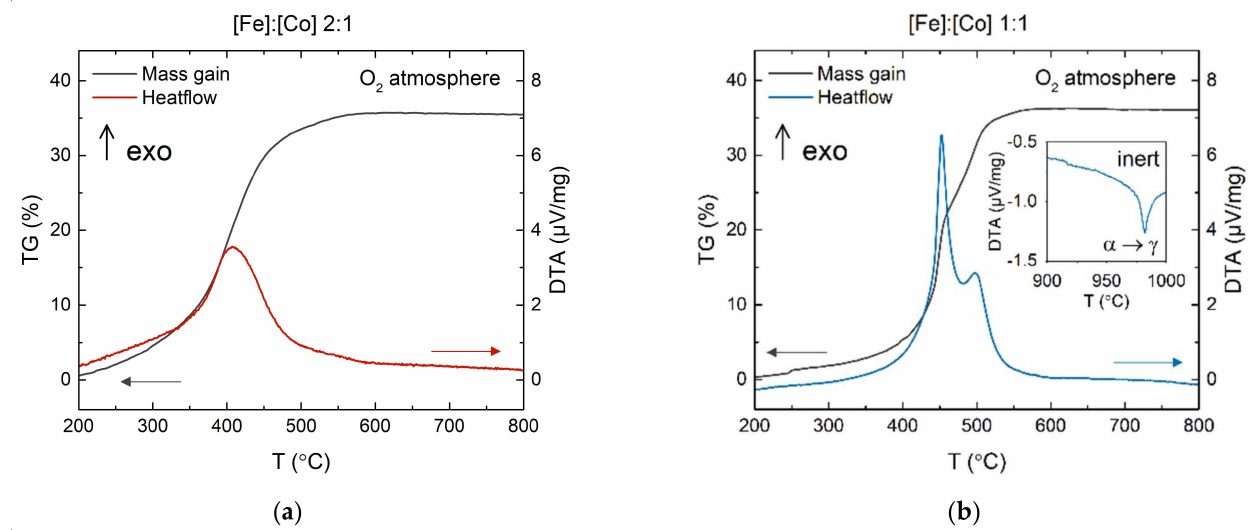
Figure 3. DTA (red or blue) and TG (black) curves recorded in the O 2 atmosphere for ( a ) Fe 66 Co 34 and ( b ) Fe 50 Co 50 MNPs. The inset of ( b ) is the DTA curve of the Fe 50 Co 50 MNPs measured in an Ar